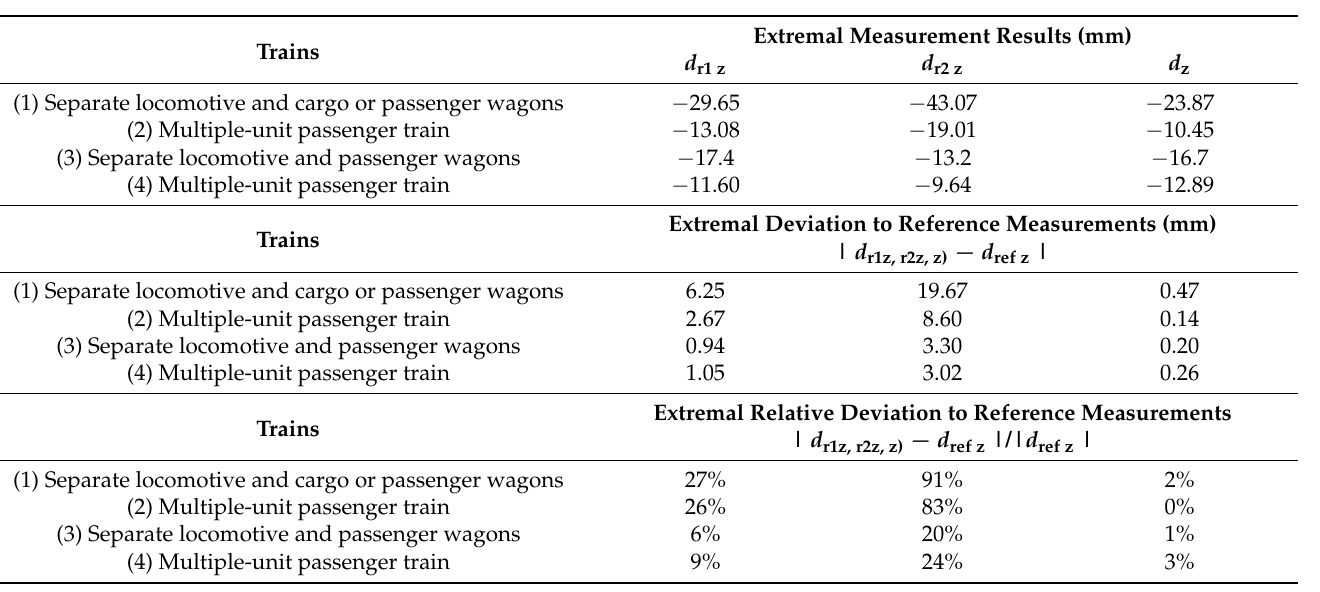
Table 1. Bridge No. 1—summary of comparative research (cross-section No. 1: trains 1 and 2, cross-section No. 2: trains 3 and